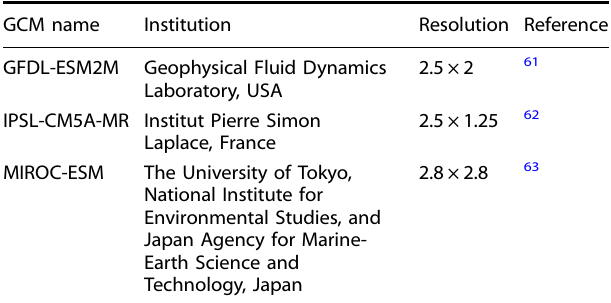
Table 2. CMIP5 GCMs used as initial and boundary conditions in the downscaling